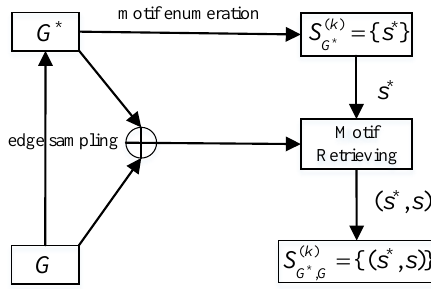
Figure 4. Overview of Mosar.